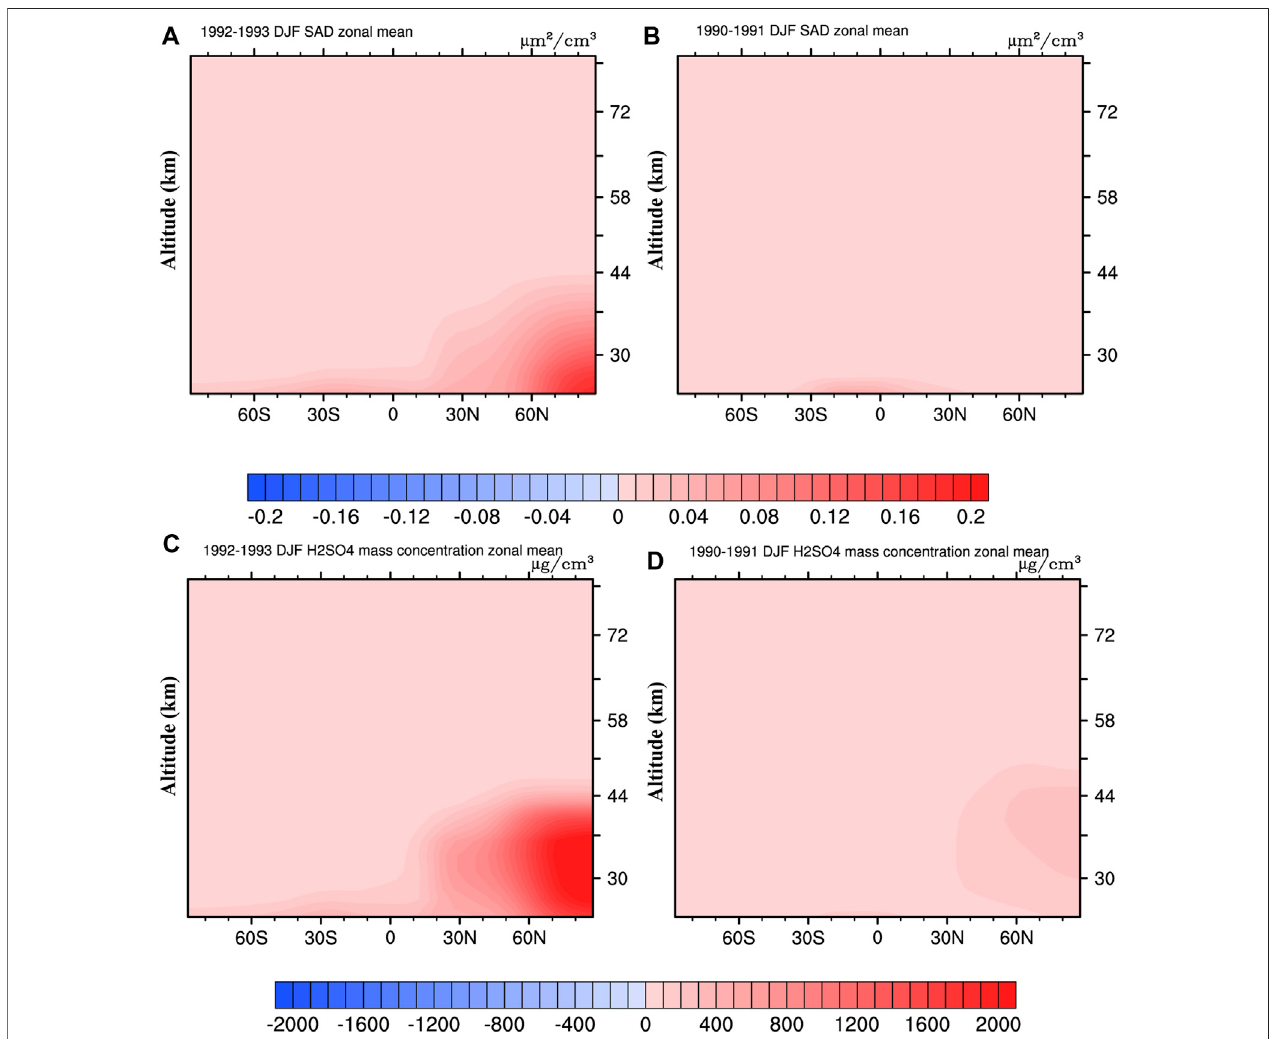
FIGURE4| Thecharacteristicsofsulfateaerosolsinthemiddleandupperstratosphere(panels (A) and (B) )andsulfatemassconcentration(panels (C) and (D) )as a function of altitude above 23 km.